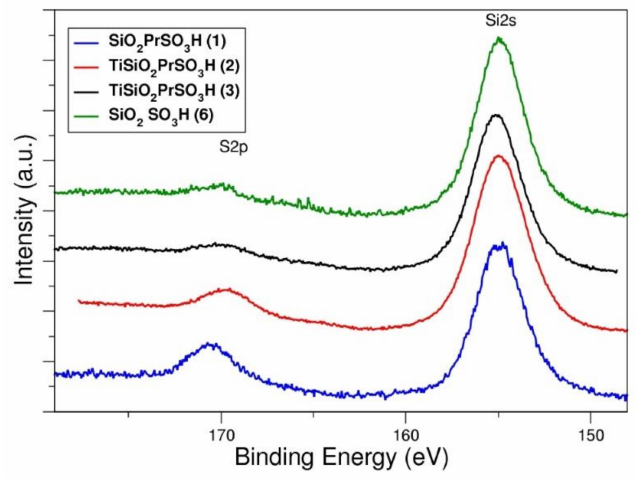
Figure 4. XPS spectra of propylsulfonic silica-based materials ( 1, 2, 3 and 6